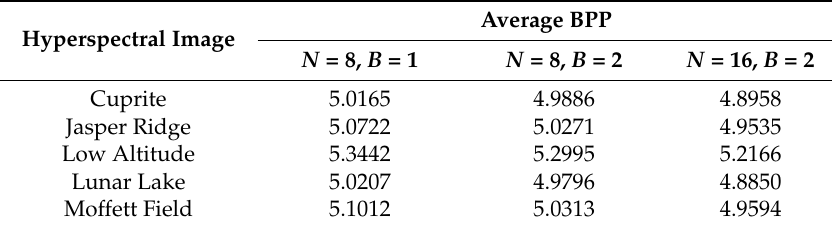
Table 7. Achieved results in terms of BPP (Dataset 1).